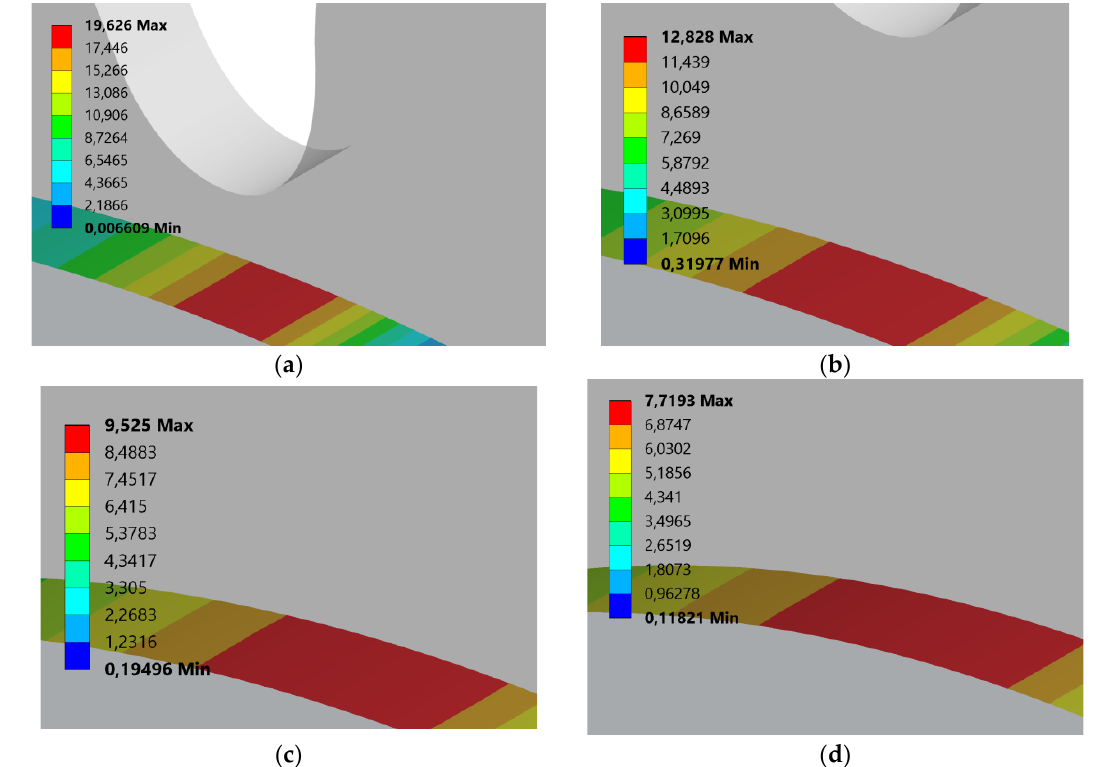
Figure 22. Shear stress results for hybrid gears with α d = 30° for different RTs; ( a ) 0.5 xm, ( b ) 1 xm, ( c ) 1.5 xm, ( d ) 2 xm .